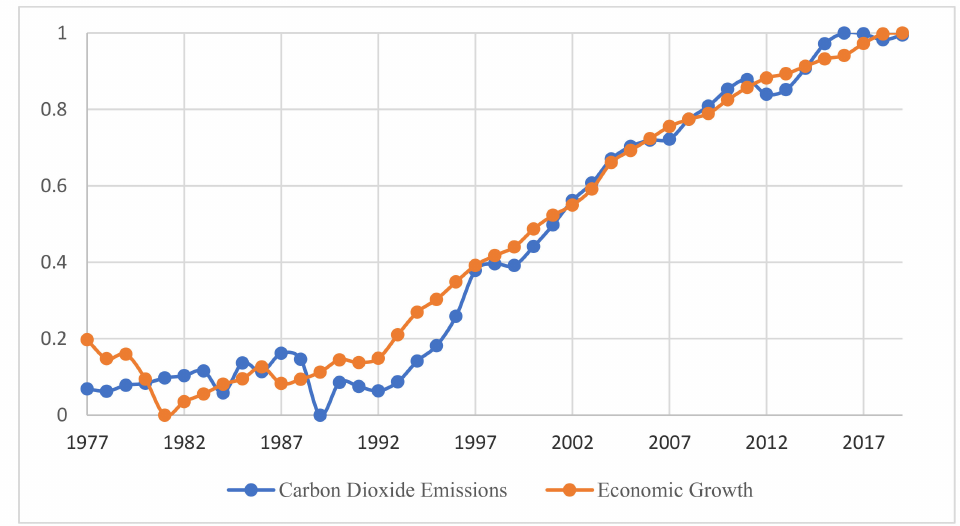
Figure 1. Evolution of carbon dioxide emissions and economic growth (normalized values),